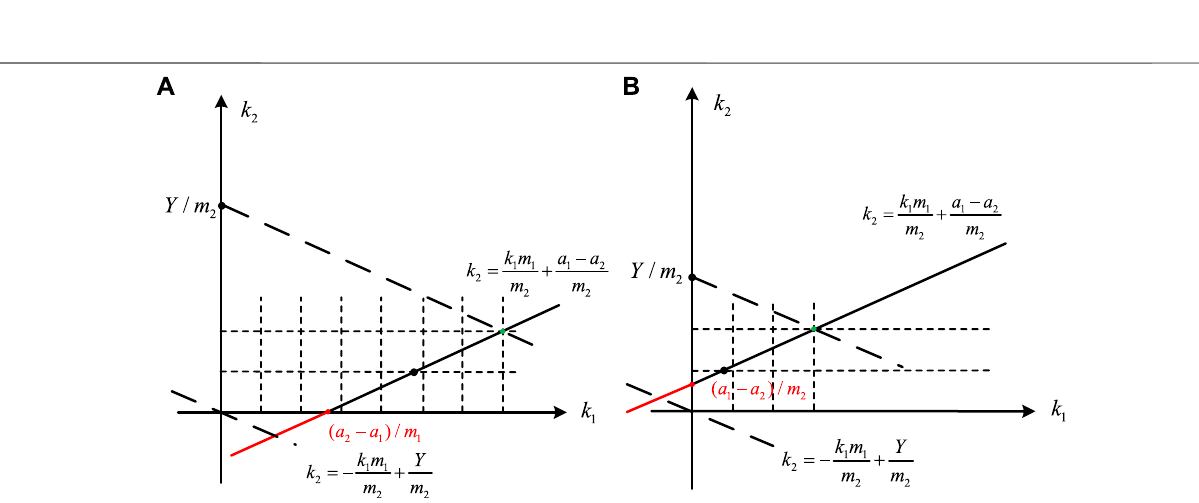
FIGURE6|(A) Schematicdiagramof k 2 increasingsequentiallywhena 2 > a 1 and m 1 / m 2 < 1. (B) Schematicdiagramof k 2 increasingsequentiallywhena 2 < a 1 and m 1 / m 2 <